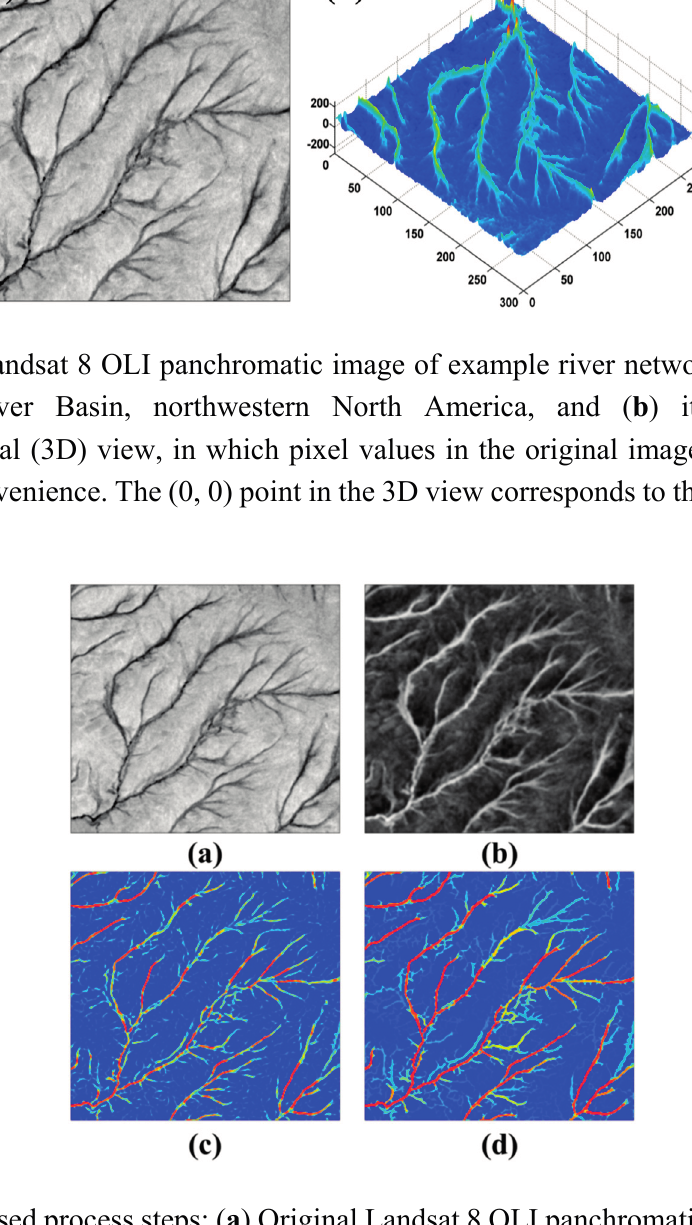
Figure 2. Proposed process steps: ( a ) Original Landsat 8 OLI panchromatic river image, ( b ) pre-processed river image, ( c ) image after Gabor filtering, and ( d ) image after path opening. The thickness of the Gabor filter, w , was set to 2 and the length threshold, L min , in the path opening was set to 40